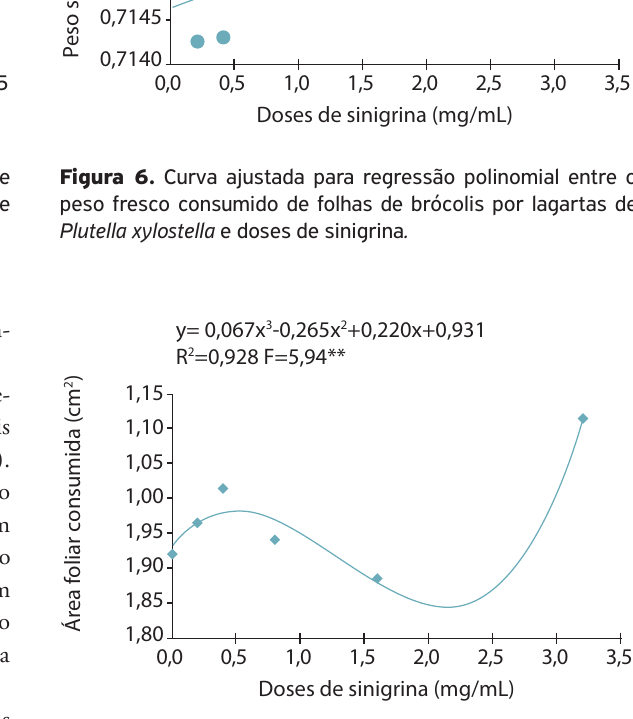
Figura 7. Curva ajustada para regressão polinomial entre a área foliar consumida de folhas de couve por lagartas de Plutella xylostella e doses de sinigrina .